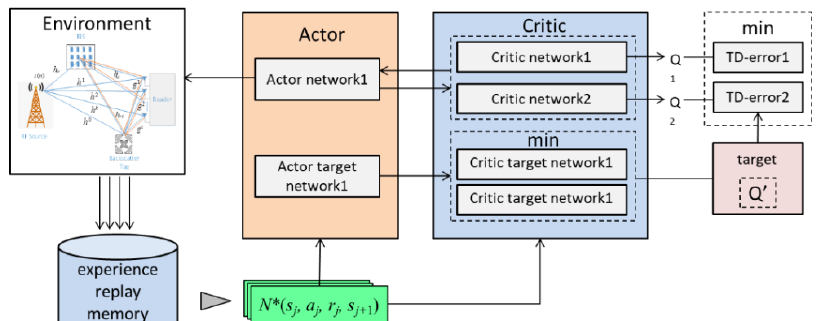
Figure 2. The TD3-based framework.